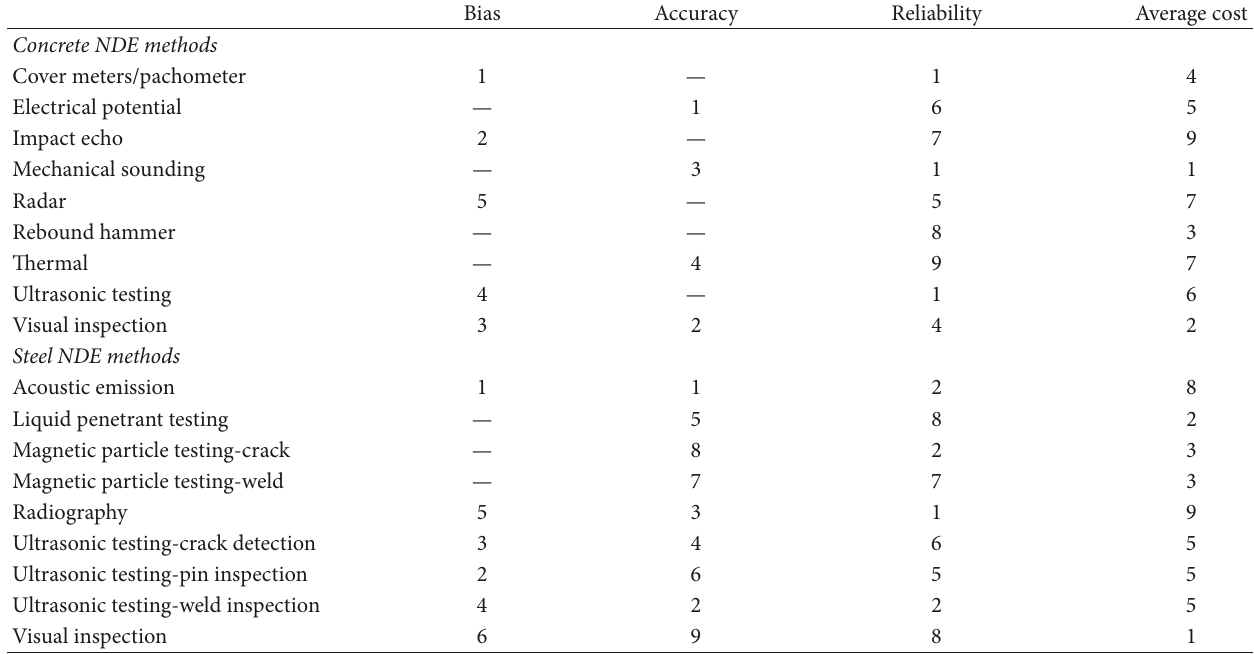
Table 8: Comparison of NDE methods using rankings indicated by participant